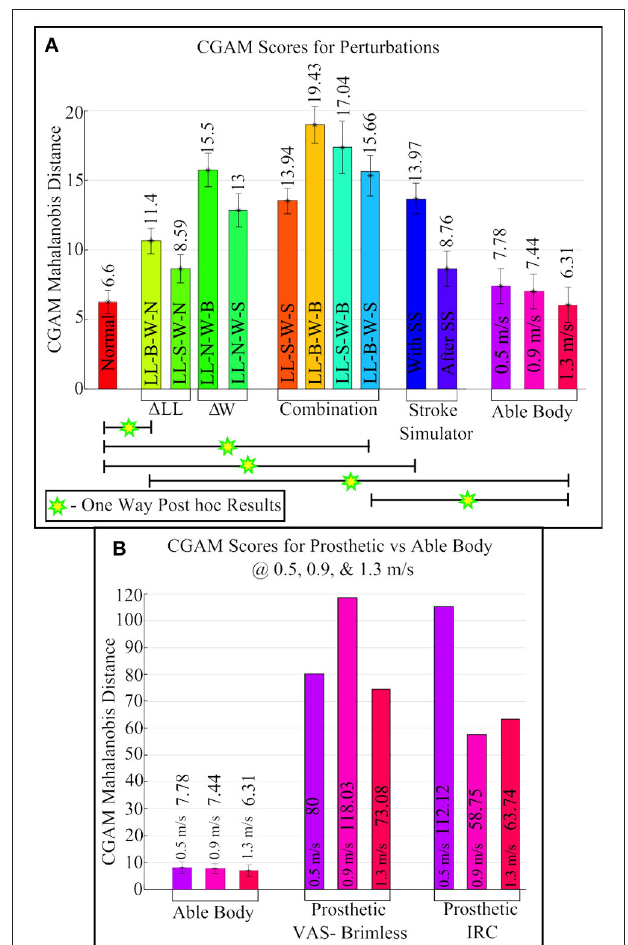
FIGURE 6 | CGAM scores for all perturbations. (A) Able-bodied subjects with multiple physical asymmetries. (B) Comparison of Able-body subjects to prosthetic user at three different speeds (0.5, 0.9, and 1.3 m/s).